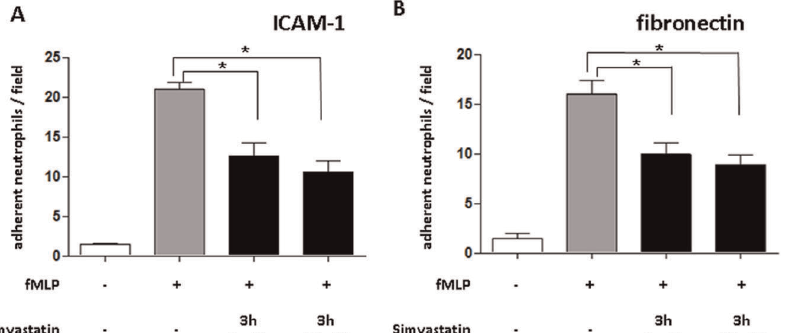
Figure 3. Simvastatin impairs neutrophil adhesion. Isolated human neutrophils were pre-treated with simvastatin (3 hours, 1 or 10 m M) and then activated with fMLP. Neutrophils were perfused over immobilized recombinant ICAM-1 or fibronectin at 1 dyne/cm 2 and the number of adherent cells was enumerated. n=8–10 for flow chamber experiments (repetition of the experiment=4). Statistical significance was tested using one way ANOVA with Newman-Keuls Multiple Comparison test.* indicates significant difference of fMLP treated samples compared to each other samples.